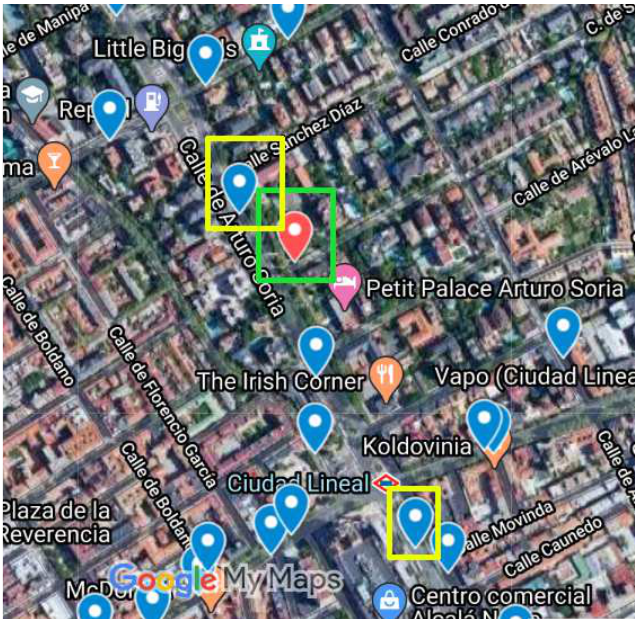
Figure 7. Considered air pollution station (highlighted by the green rectangle) and traffic flow sensors (highlighted by the yellow